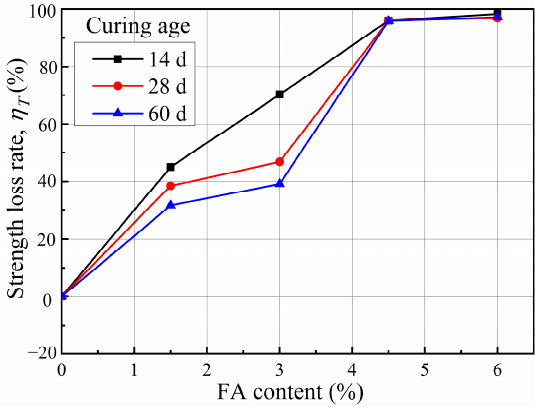
Figure 5. The η T of CDS versus FA content and curing age.